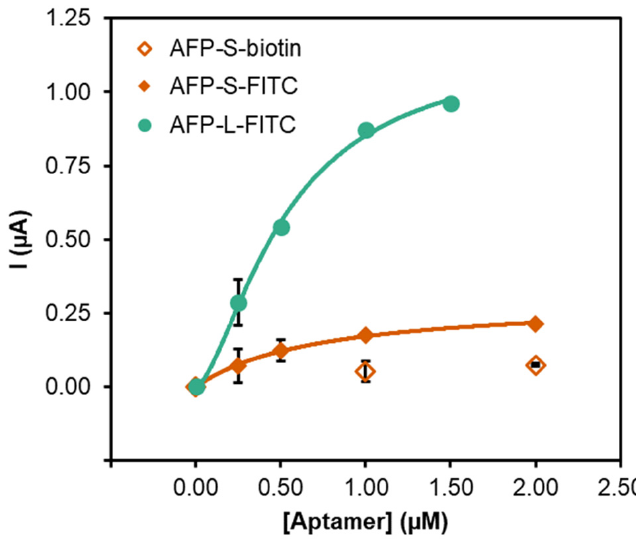
Figure 1. Binding curves obtained with AFP-modified MBs and the biotinylated or fluorescein-tagged short aptamer and the fluorescein-tagged long aptamer.